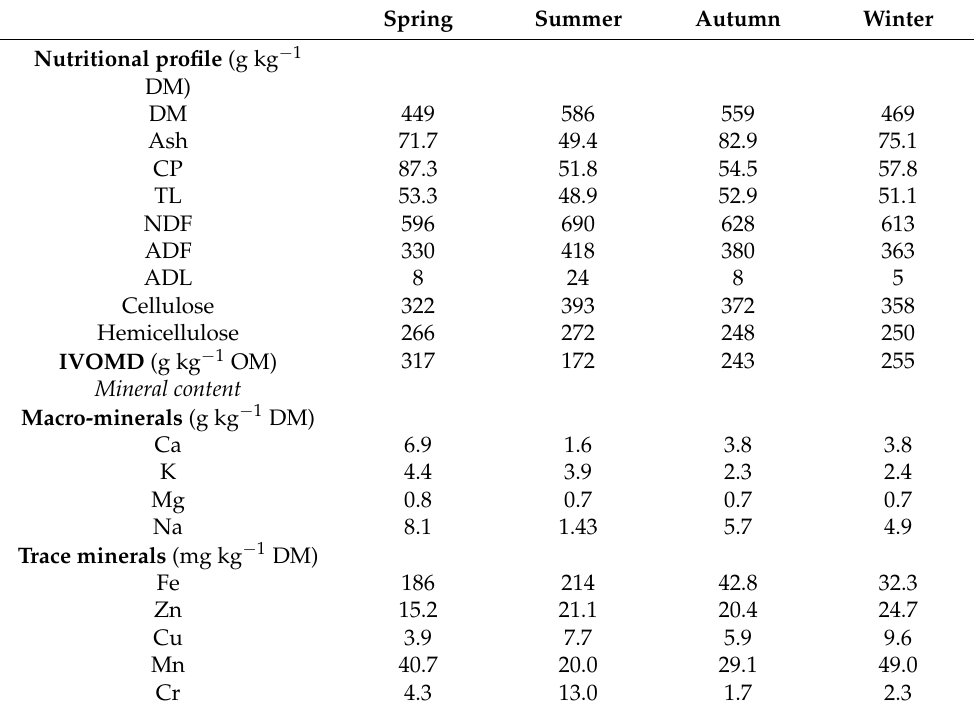
Table 1. Seasonal effects on the nutritional value, in vitro digestibility, and mineral content of aerial parts of sawgrass ( C. mariscus )